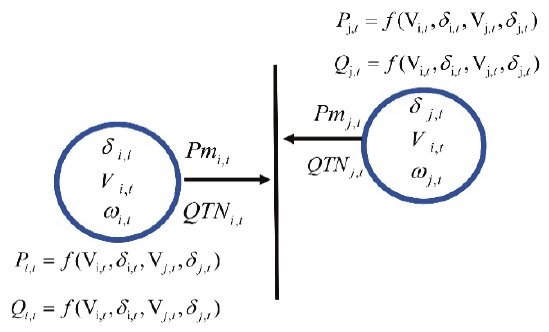
Figure 2. Local systems’ variables detail.